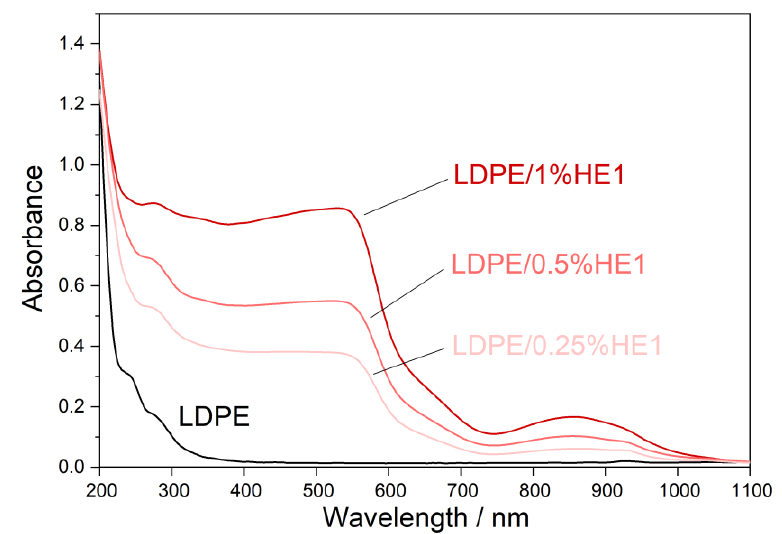
Figure 7. Absorbance UV-Vis-NIR spectra (obtained from diffuse reflectance) of LDPE and LDPE/HC2 composites.